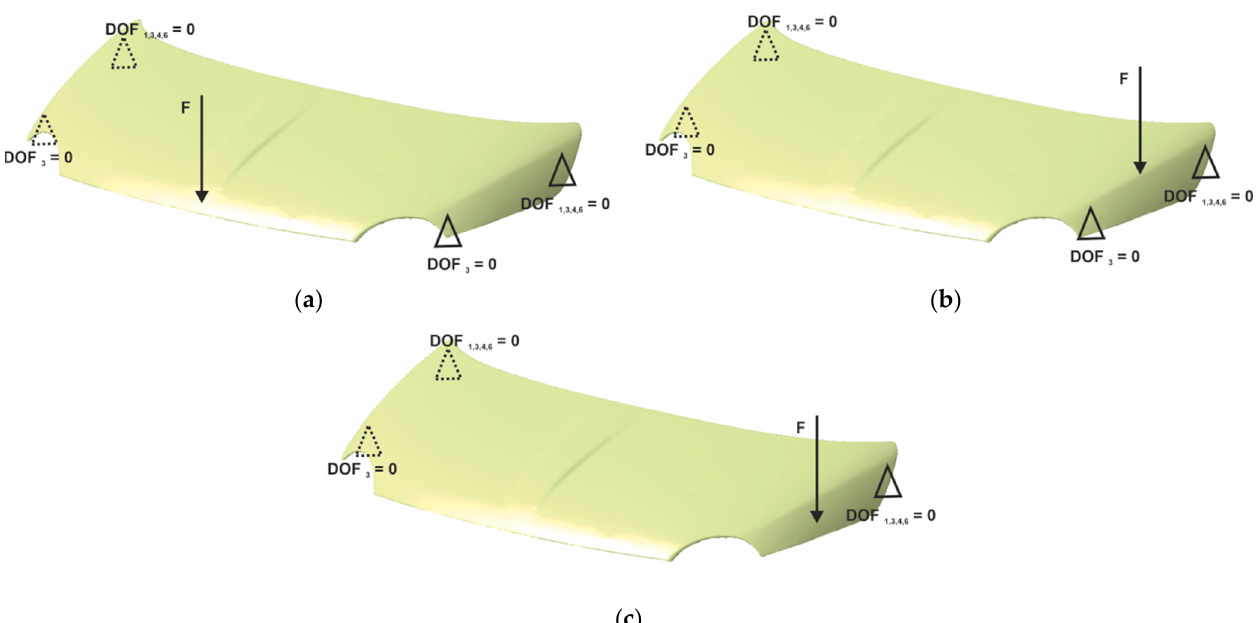
Figure 12. Boundary conditions used for evaluation of: ( a ) lateral stiffness, ( b ) transversal stiffness and ( c ) torsional stiffness.